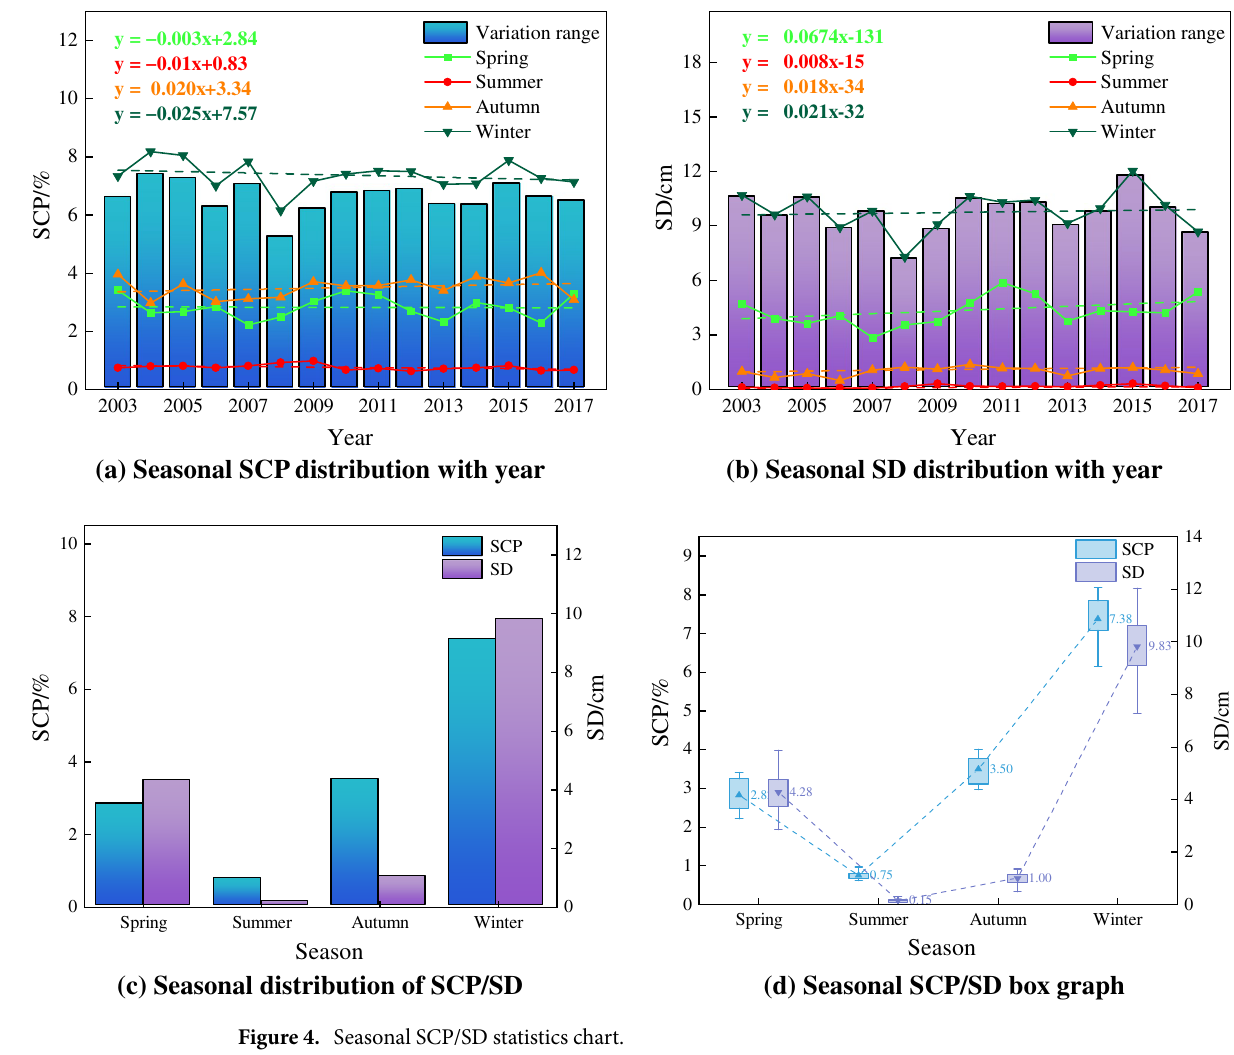
Figure 4. Seasonal SCP/SD statistics